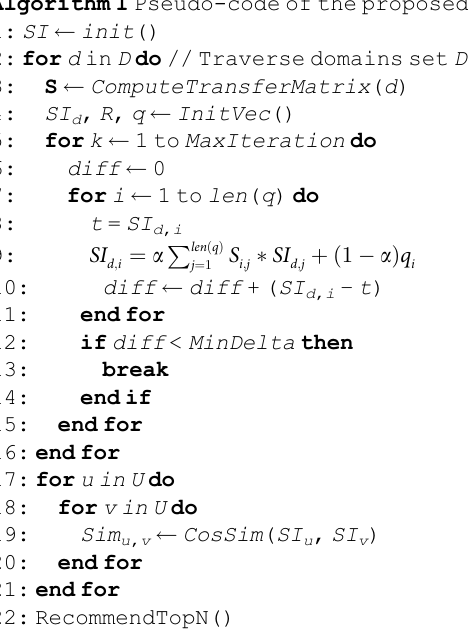
Algorithm 1 Pseudo-code of the proposed